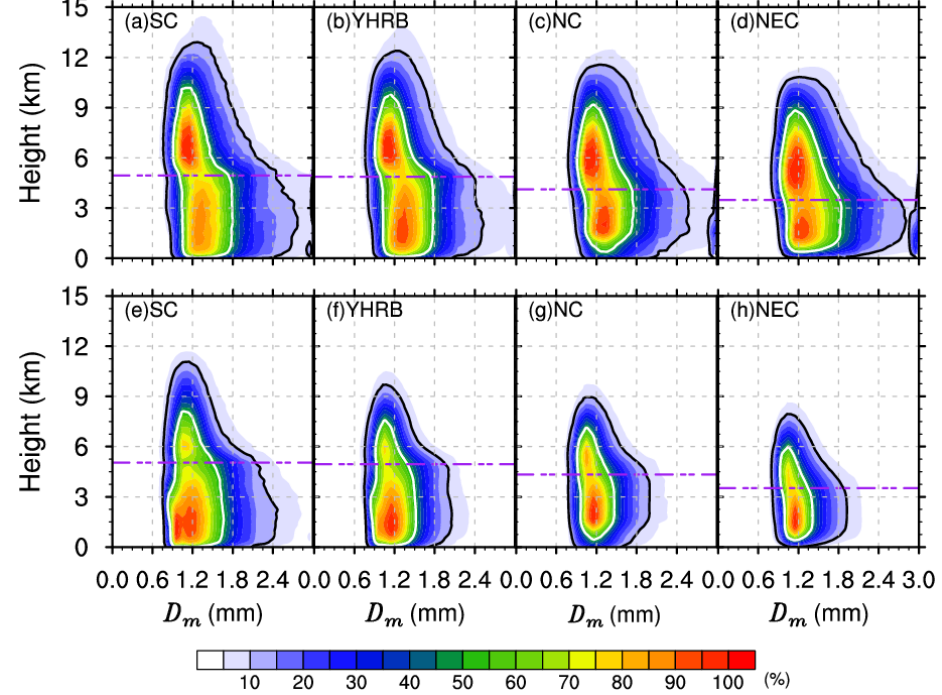
Figure 8. Similar to Figure 7, but for D m . The bin sizes for D m and height are 0.1 mm, 250 m, respec- tively.